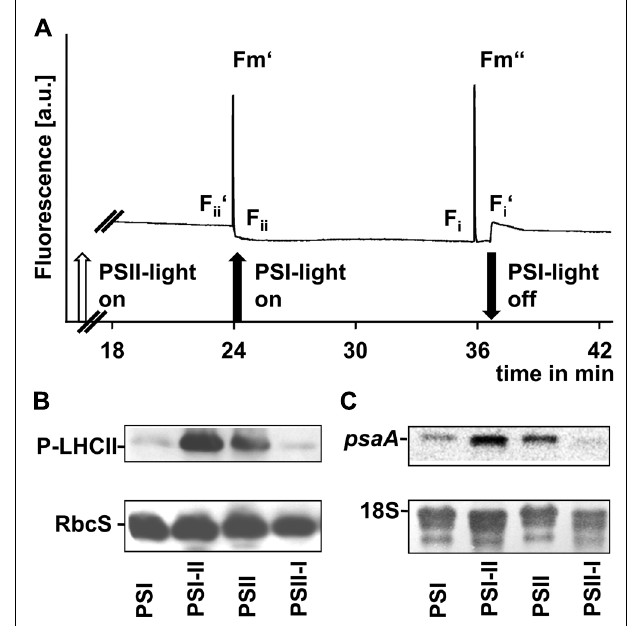
FIGURE 5 | Redox-controlled processes in photosynthetic acclimation of maize seedlings. (A) Artificial growth lights were used as actinic light sources in state transition experiments to indicate the short-term redox effects on linear electron transport. Chl fluorescence given in arbitrary units was recorded using a PAM fluorometer. Measurements were done three times with leaves from three different biological samples. A typical trace is shown. On–off switches of the lights are given below the trace. Nomenclature of fluorescence parameters follows established conventions (see Materials and Methods). (B) Plastid protein extracts of maize seedlings grown under the different long-term light quality regimes as indicated in Section “Material and Methods” (indicated on bottom, compare Figures 3 and 4 ) were used to analyze the phosphorylation state of LHCII using a anti-phosphothreonine antibody. As loading control a corresponding experiment with the same membrane targeted to the small subunit of RubisCO (RbcS) is shown. (C) RNA isolates from the same samples isolated in parallel were used to determine the accumulation of psaA transcripts by northern analysis. As loading control a hybridization of the same membrane with a probe directed against the 18S rRNA is